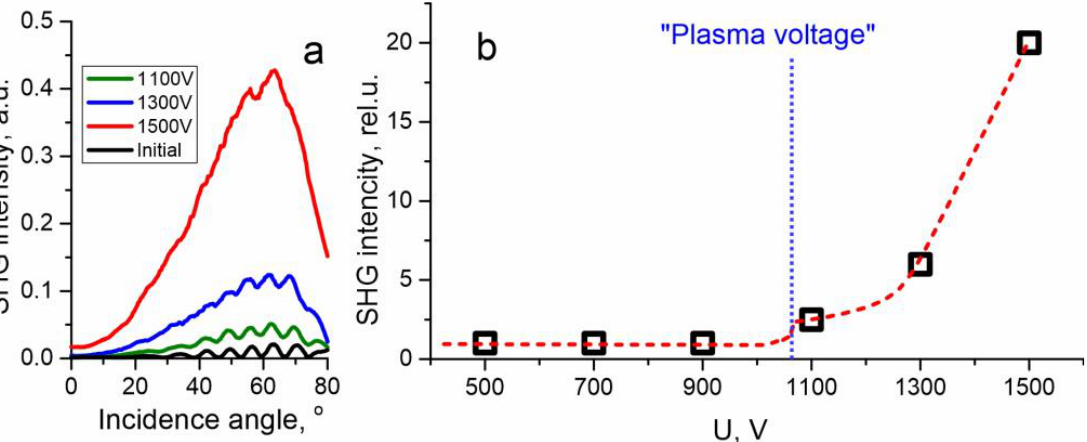
Figure 2. ( a ) Time dependencies of the current during the poling process of Menzel glass specimens subjected to different voltages. ( b ) Dependence of charge passed during 20-min-poling on the voltage applied (dashed curve is a guide for an eye); the characteristic ignition voltage of plasma (“plasma voltage”) is indicated.